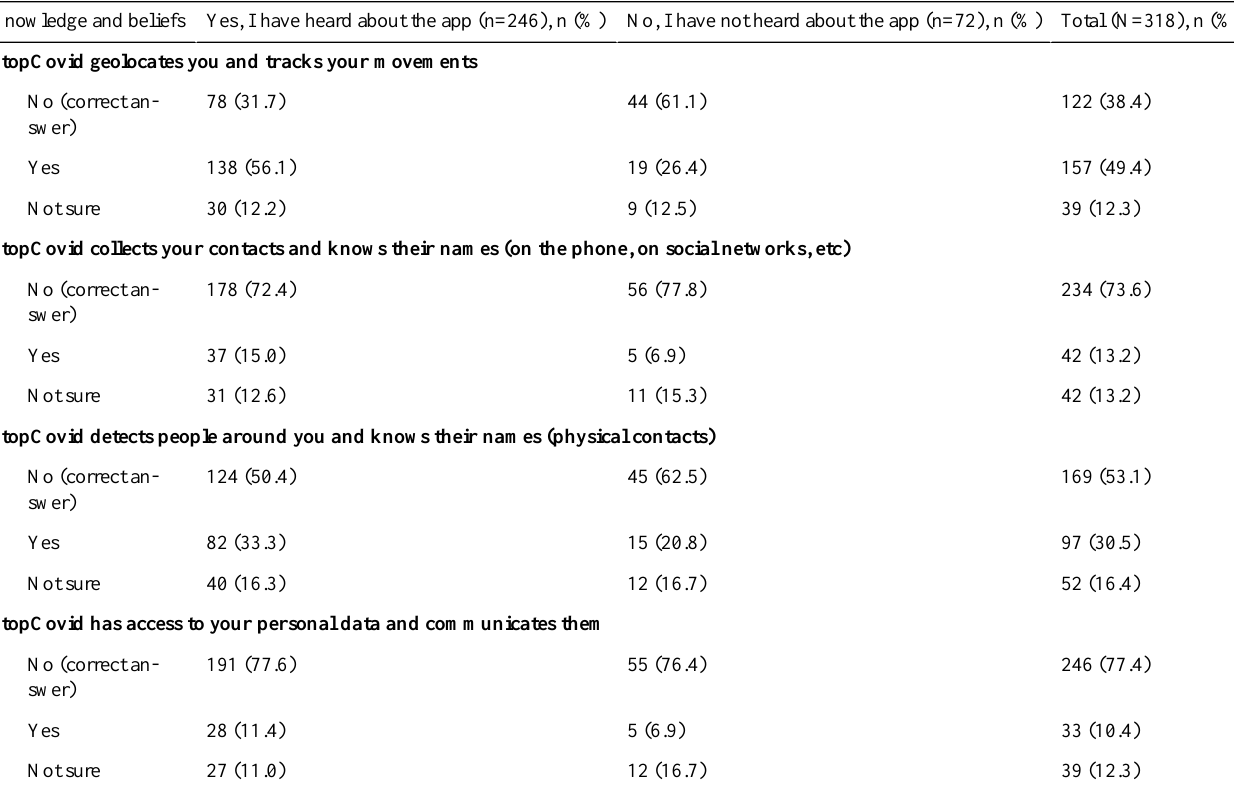
Table 4. Knowledge and beliefs about the functioning and data management of the StopCovid app. StopCovid geolocates you and tracks your